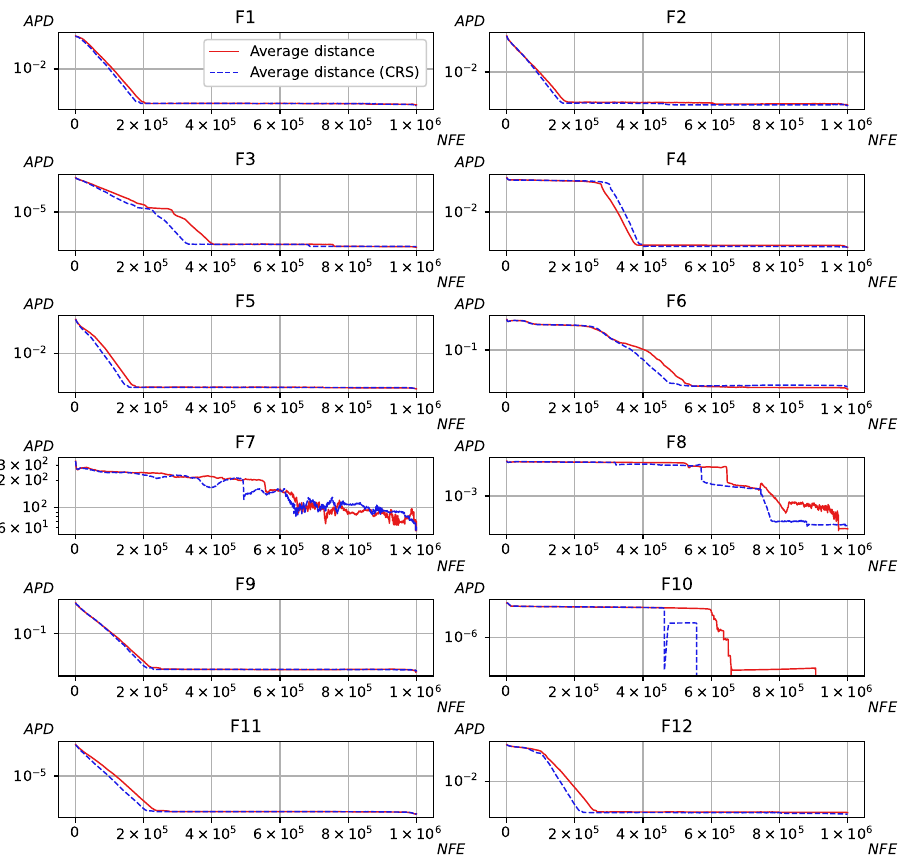
Figure 2. Average pairwise distance between individuals in the newest population, L-NTADE, CEC 2022, 20 ∗ D